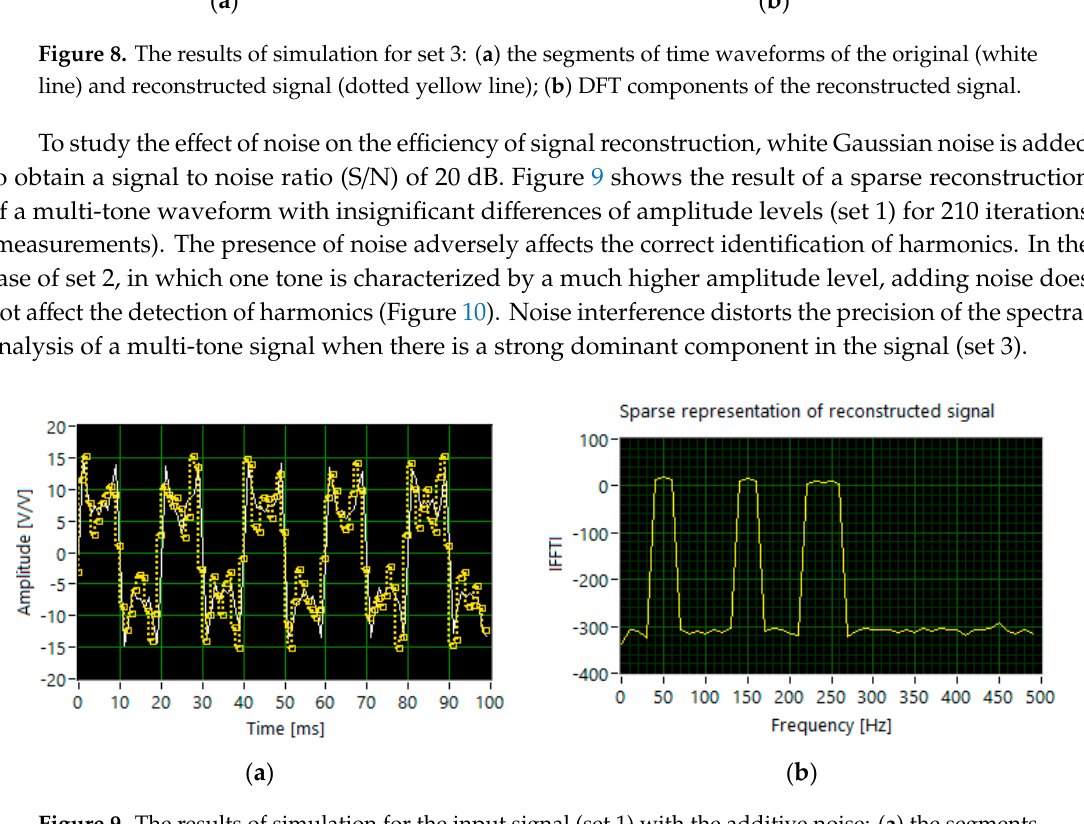
Figure 8. The results of simulation for set 3: ( a ) the segments of time waveforms of the original (white line) and reconstructed signal (dotted yellow line); ( b ) DFT components of the reconstructed signal.